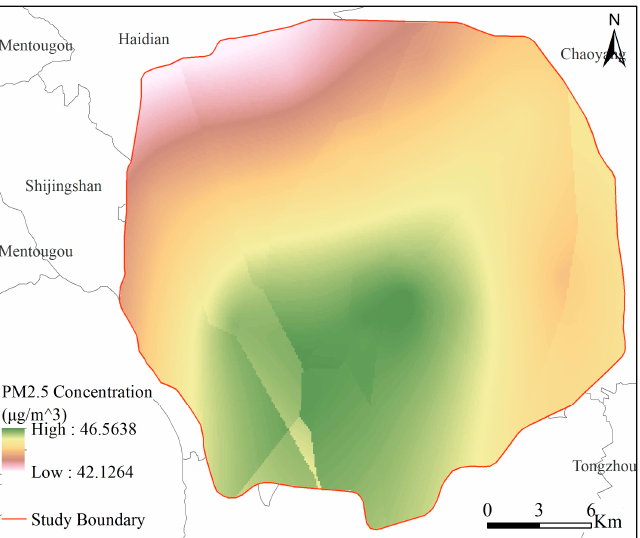
Figure 3. Distribution of particulate matter with an aerodynamic diameter <2.5 µ m (PM 2.5 ) in study area.